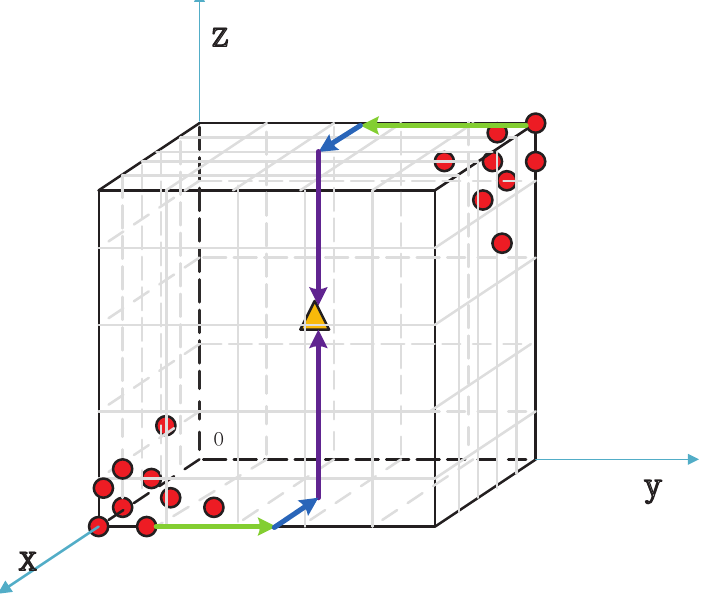
Figure 3. The basic schematic diagram of the Particle Swarm Optimization—Correlation Electromag- netic